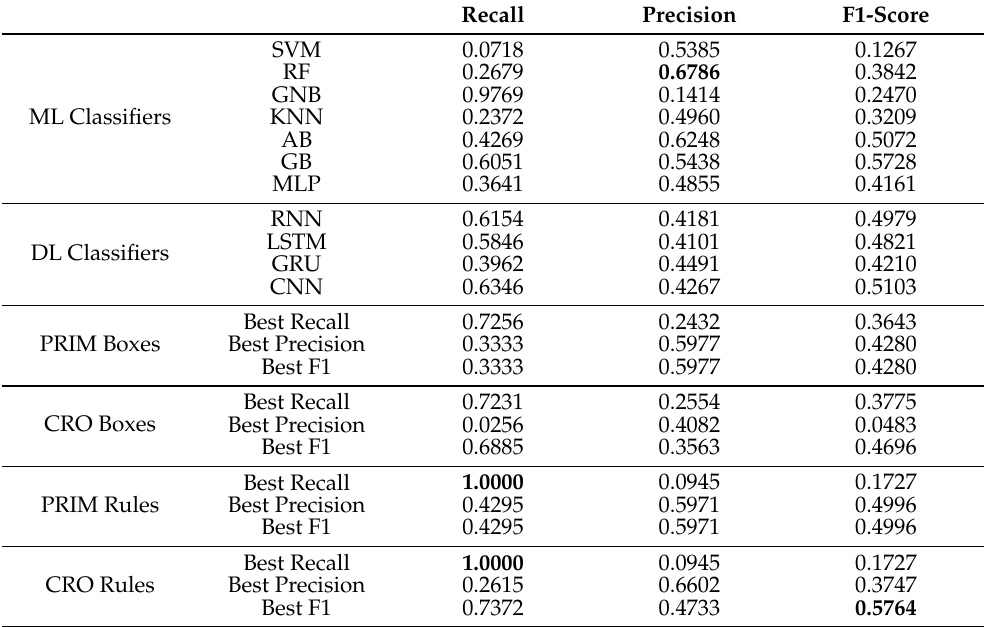
Table A2. Test results for all the classification methods evaluated, considering a time prediction horizon of +5 h.